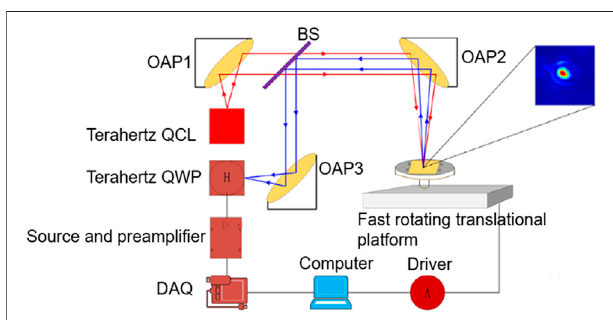
FIGURE 3 | The fast scanning imaging system